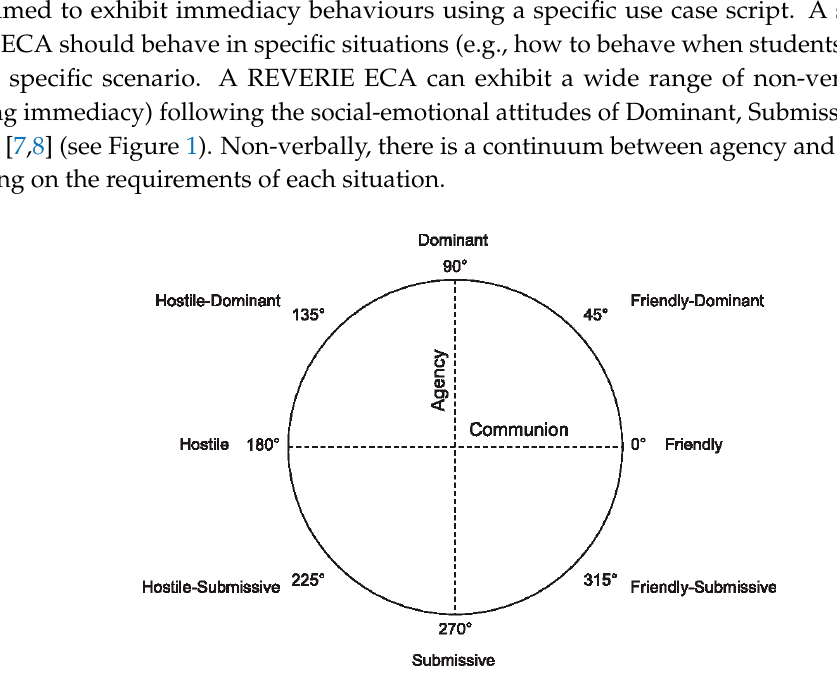
Figure 1. The Interpersonal Circumplex.